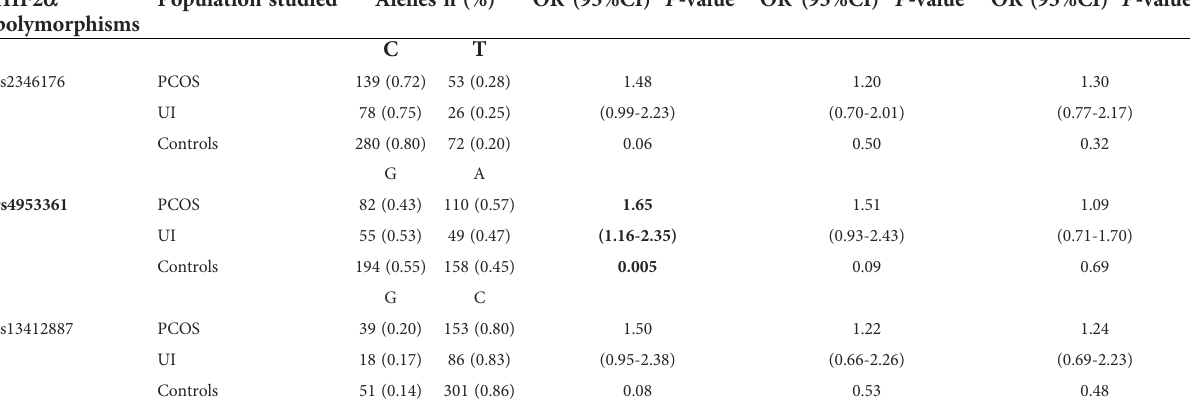
TABLE 2 Allele frequencies of the HIF2 a polymorphisms in infertile patients with PCOS or UI and in the control group. HIF2 a Population studied polymorphisms